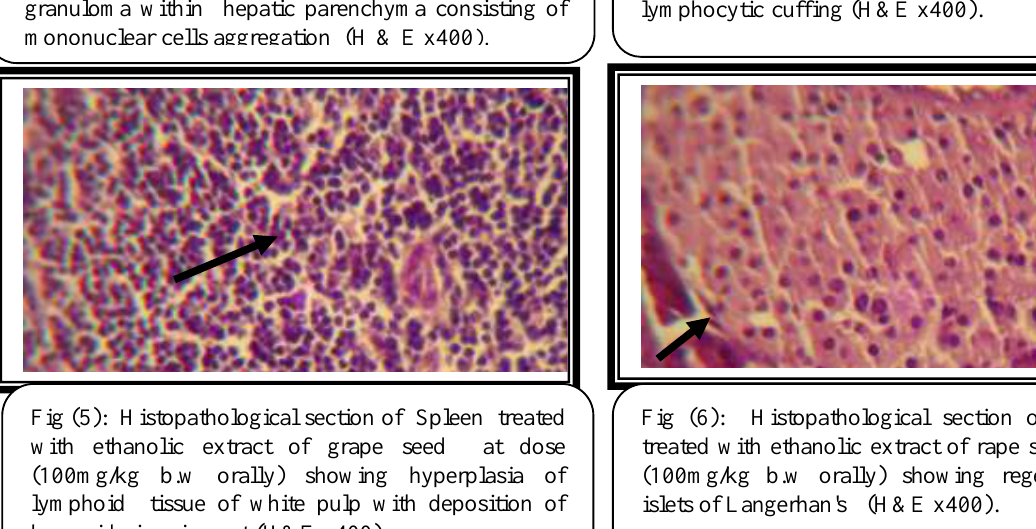
Fig (4): Histopathological section of Kidney treated with ethanolic extract of grape seed at dose (100mg/kg b.w orally) showing perivascular lymphocytic cuffing (H&E x400).